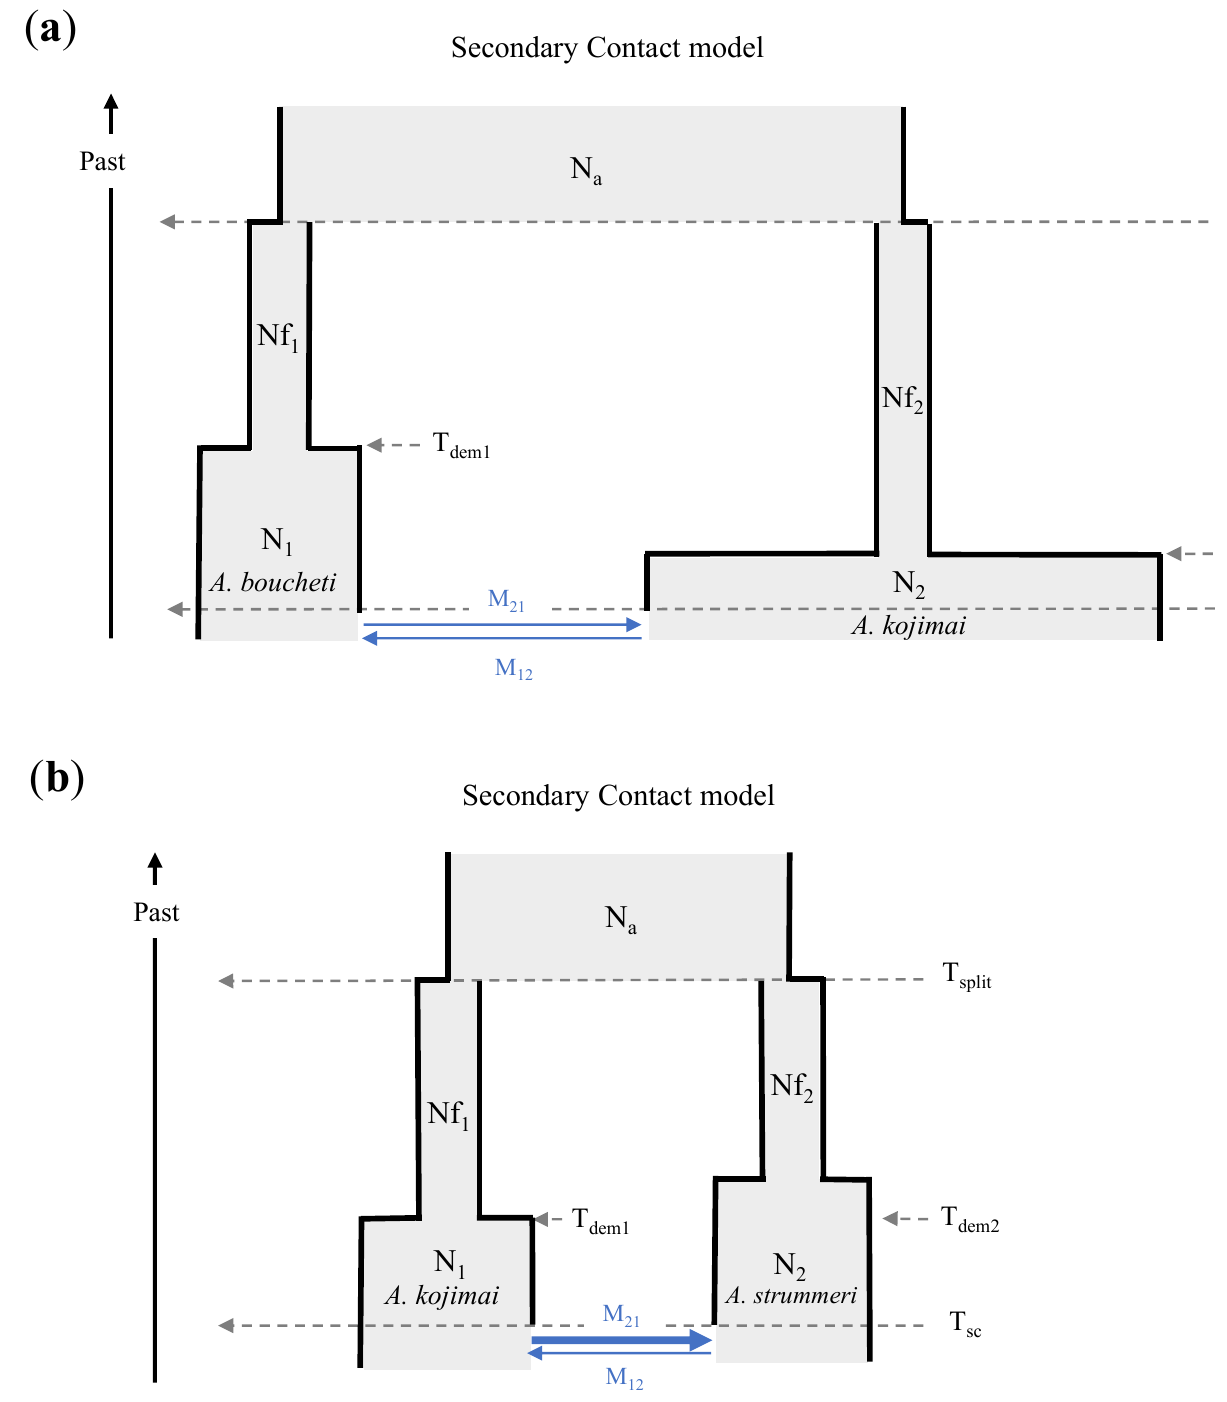
Figure 9. Demographic models that best explained the data observed in this study. N 1 and N 2 : effective size of population 1 and 2; N a : effective size of the ancestral population; Nf 1 and Nf 2 : effective size of population 1 and 2 after the split (differences in population size parameters are approximately reflected by the width of each box); T split : time of split at which the ancestral population subdivides in two populations; T dem : time of the expansion of the population; T sc : time of secondary contact at which the two populations start exchanging genes; M 12 and M 21 : introgression rates from population 2 to 1 and from population 1 to 2, respectively (blue arrows). ( a ) Analysis for A. boucheti / A. kojimai ; ( b ) analysis for A. kojimai / A. strummeri . Separation between the ancestral population and the two daughter populations was old (for analyses yielding the best fit, T split : around 141,340 and 133,200 generations for A. boucheti/A. kojimai and A. kojimai/A. strummeri , respectively) and preceded the period of population expansion (T dem1 : 35,140/T dem2 : 10,200 and T dem1 : 25,740/T dem2 : 55,500 generations for A. boucheti/A. kojimai and A. kojimai/A. strummeri , respectively). Then, a period of